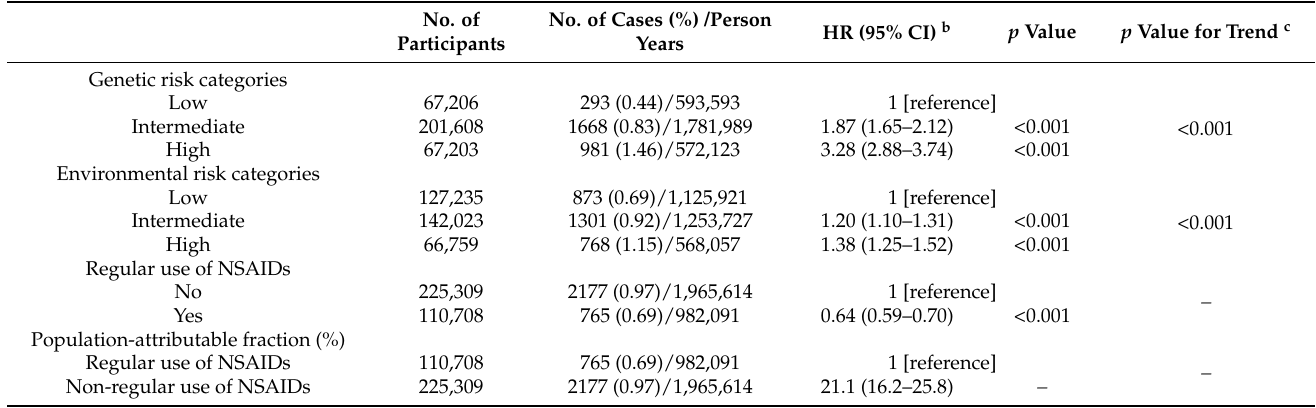
Table 2. The multivariate-adjusted hazard ratio (95% CI) of risk factors associated with CRC a . No. of No. of Cases (%) /Person Participants